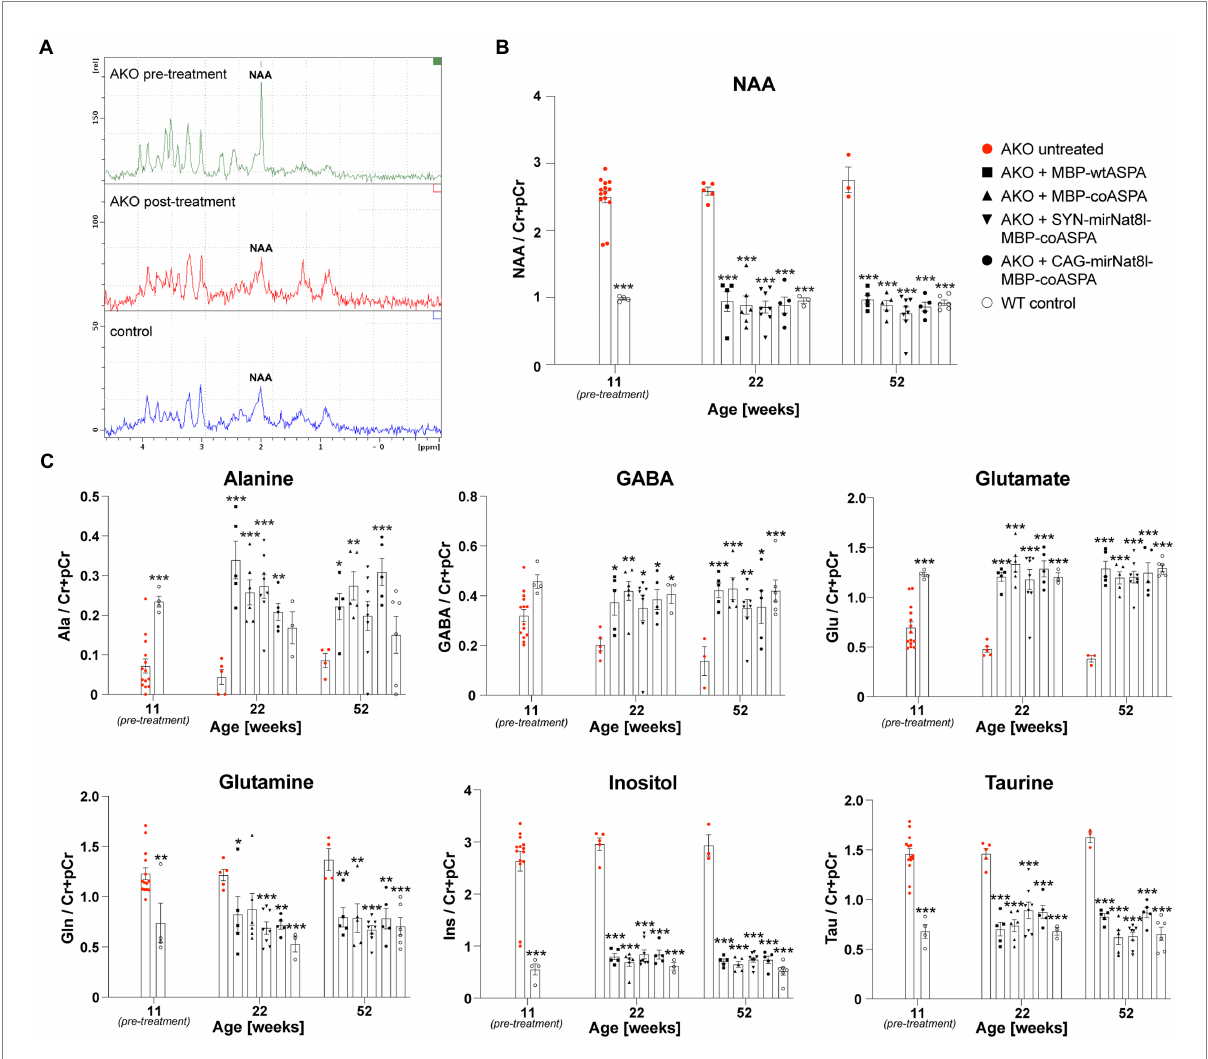
FIGURE 7 Restored brain metabolite levels in post-symptomatic AKO mice following AAV treatment. AAV vectors were injected bilaterally into striatum, thalamus, and cerebellum (3 × 10 9 vg per site) of 12-week-old AKO mice. (A) Representative 1 H-MRS spectra from AKO pre-treatment (top), post- treatment (AAV.SYN-mirNat8l.1 + 3-MBP-Aspa, middle) and from a wildtype control mouse (bottom). (B) Quantification of brain N-acetyl-L- aspartate (NAA) levels normalized to creatine and phosphocreatine (Cr + pCr) in the same group of AKO mice before gene therapy as well as